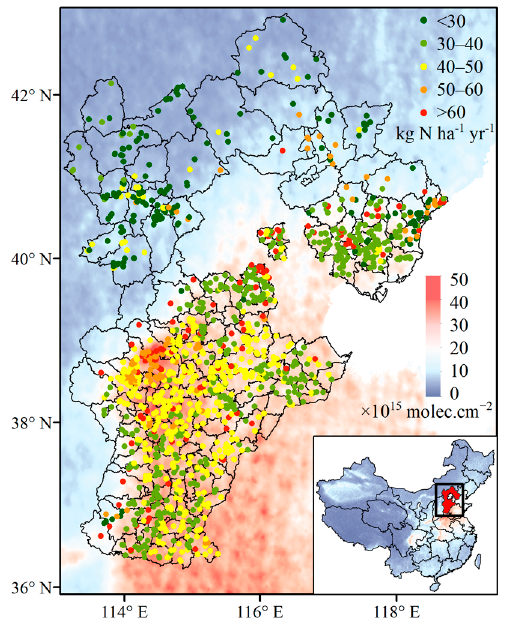
Figure 1. Estimated NH 3 emissions from livestock feedlots in Hebei province in 2020. The background shows annual average IASI NH 3 concentrations during 2018–2020.